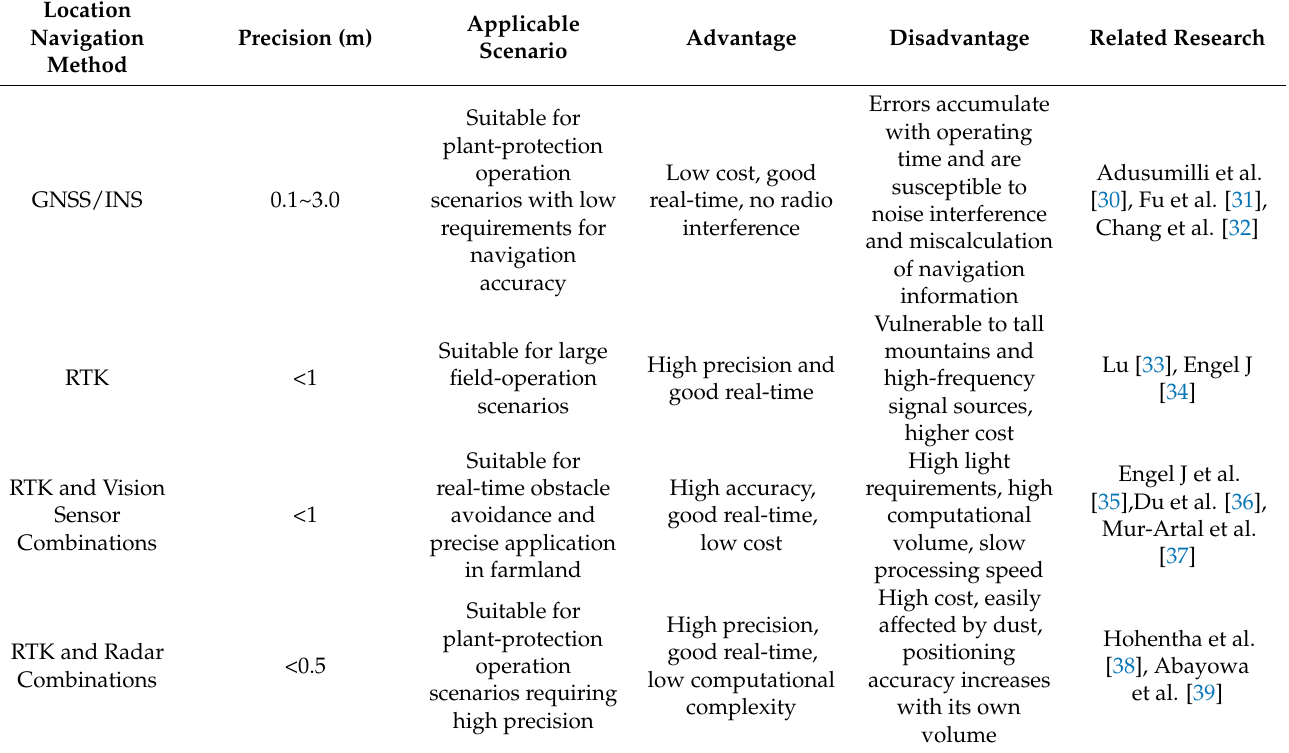
Table 1. Performance comparison of various navigation